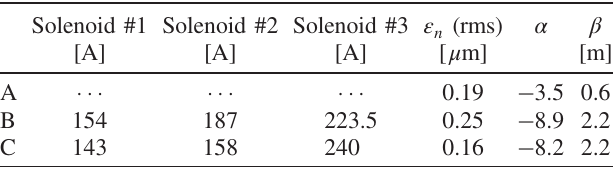
TABLE I. Phase space measurement